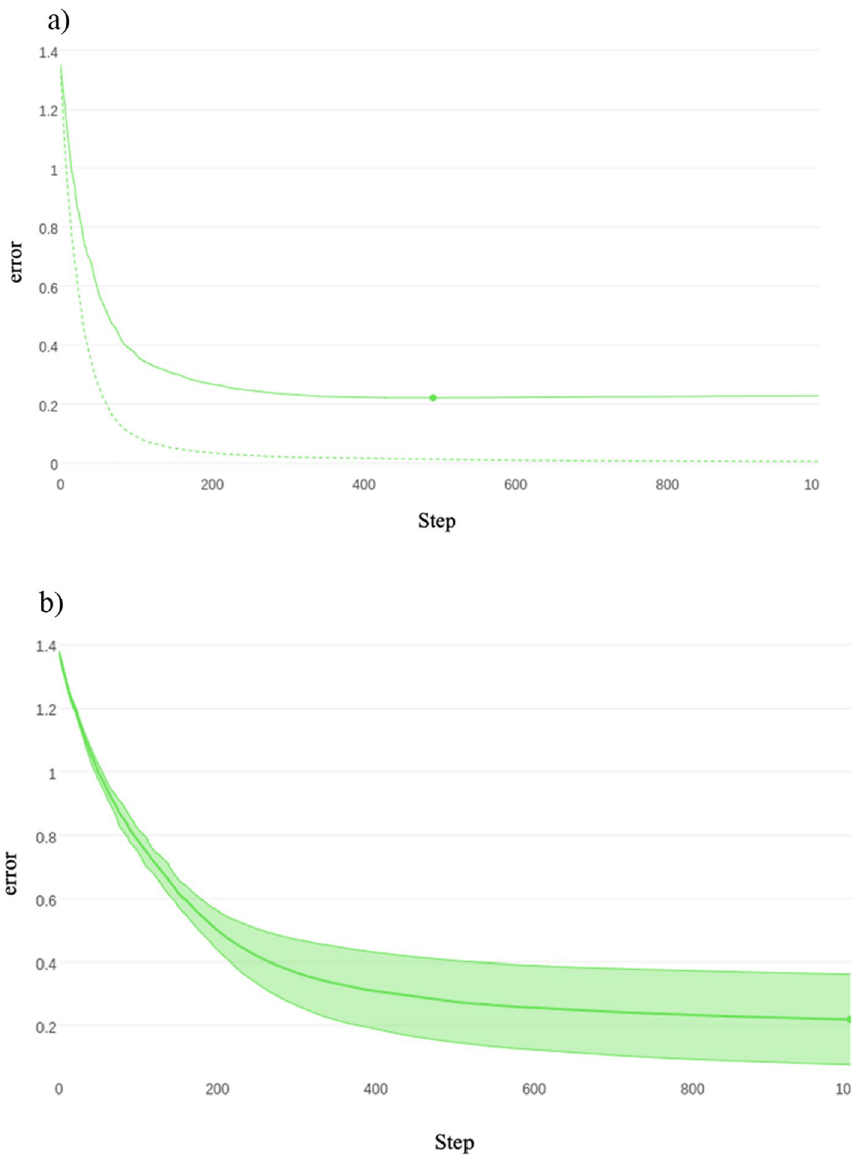
Figure 3. ( a ) Visual representation of the training (shown as the dotted line) and validation (shown as the solid line) losses for the Catboost algorithm on 4 classes. The minimum error of 0.2211 was achieved on step 491, with the training error following a similar curve indicating over fitting has not taken place. ( b ) Visual representation of the validation losses and standard deviation for the Catboost algorithm on 4 classes for threefold cross validation. The average accuracy for the threefold cross validation was 94% ± 0.05.